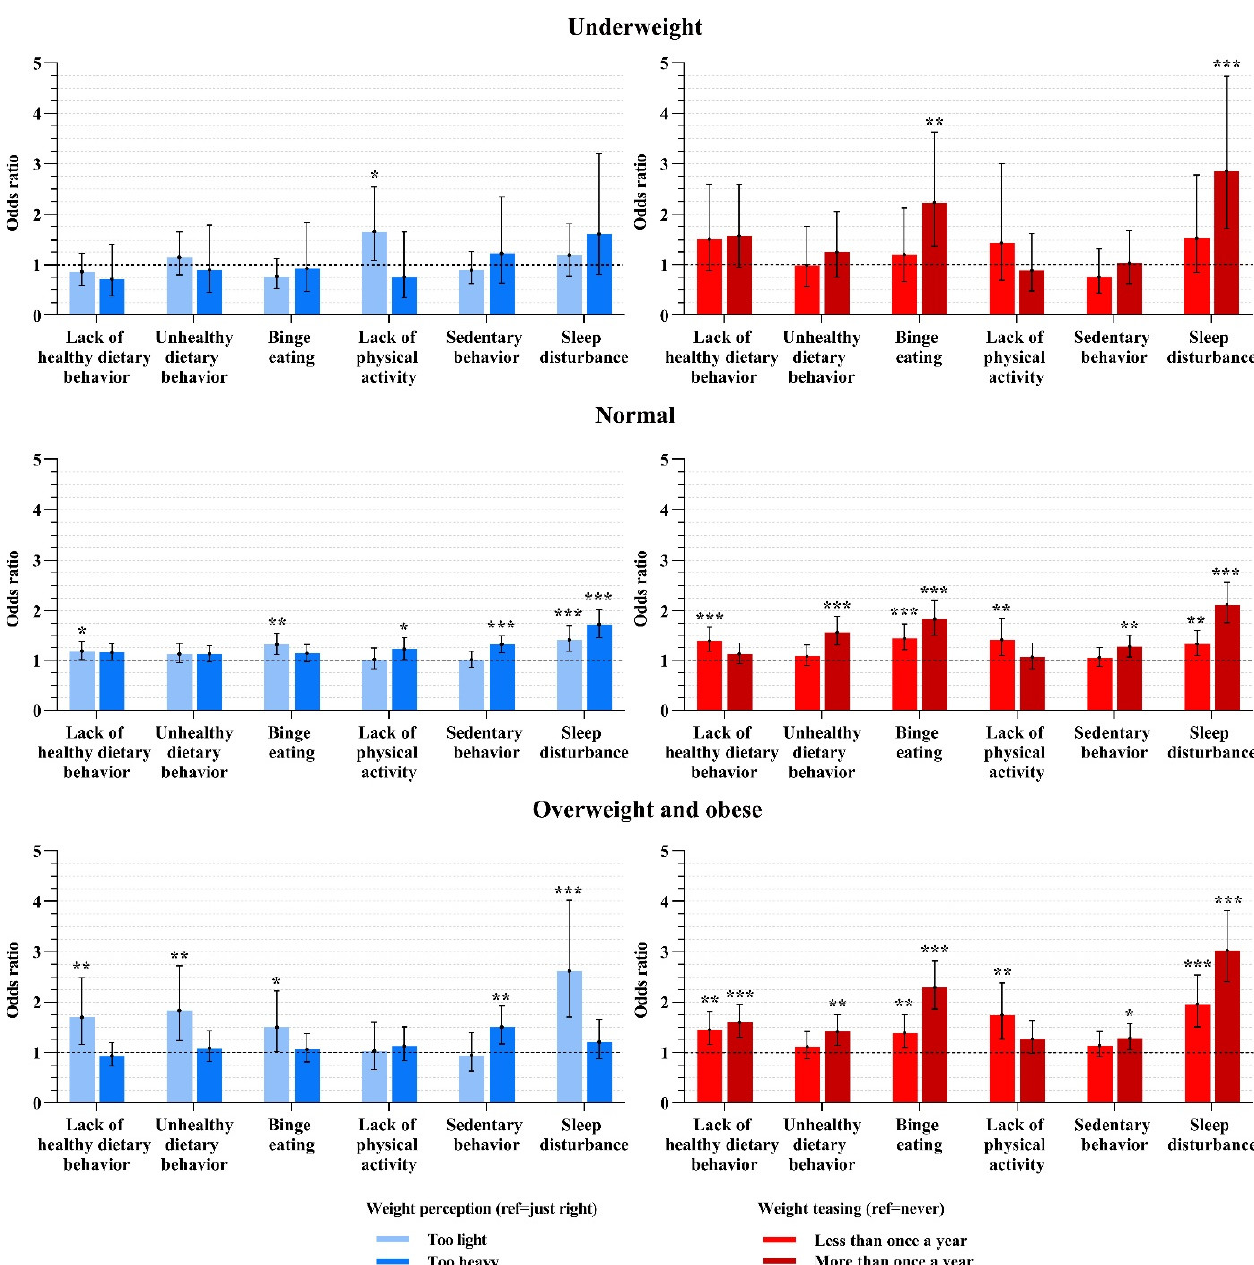
Figure 1. The association between weight perception or weight teasing and health risk behaviors according to different body weight status. Variables in the model were age, sex, registered residence, monthly pocket money, socioeconomic status, living on campus, academic performance in class, BMI, weight perception and weight teasing. * p < 0.05; ** p < 0.01; *** p < 0.001.